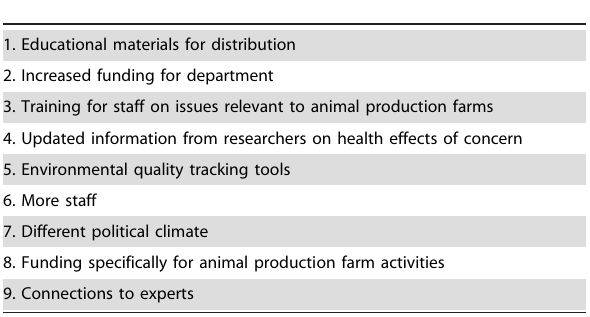
Table 2. Resources indicated by HD staff as needed to address IFAP concerns (ranked by number of HDs indicating need).